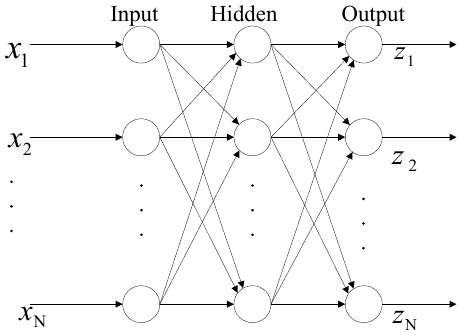
Figure 7. Architecture for three-layer ANN.